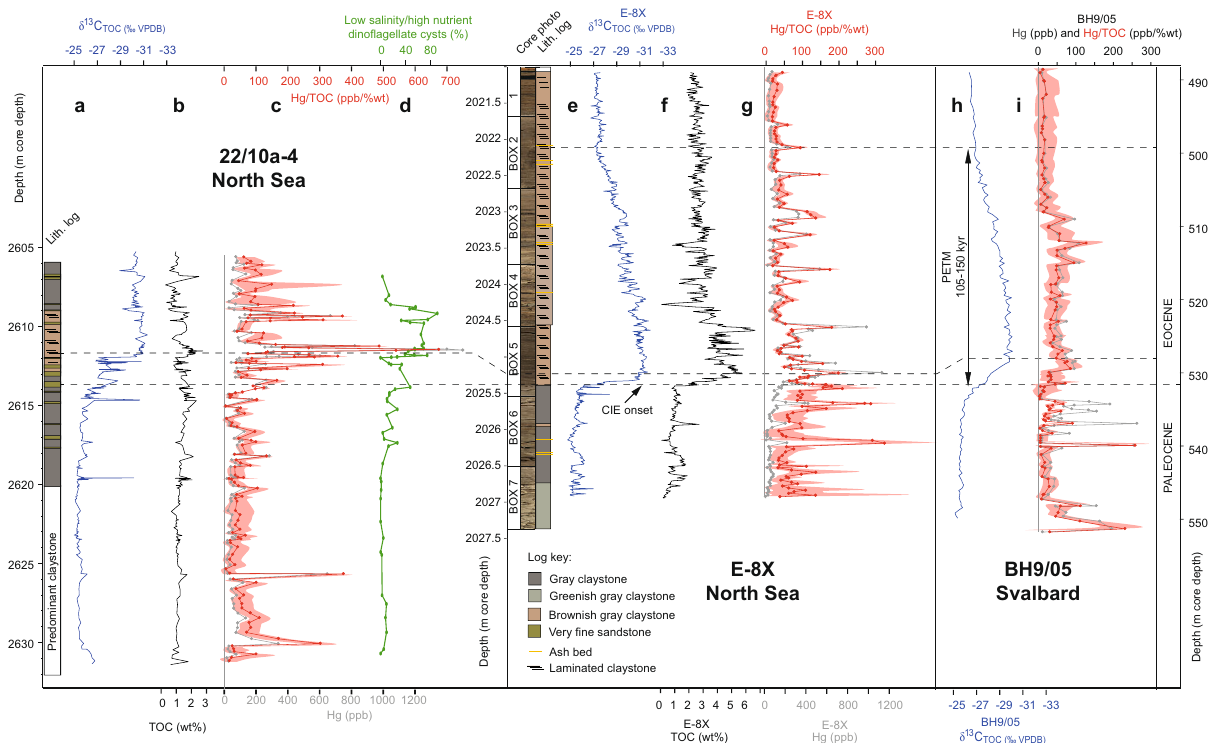
Fig. 2 Geochemical proxy records from the North Sea and Svalbard cores, showing volcanic and sedimentological changes associated with the Paleocene – Eocene Thermal Maximum (PETM). Records are shown against depth in m core depth (below oil rig fl oor ‘ Kelly bushing ’ for 22/10a-4 and E-8X). a – d Well site 22/10a-4 (North Sea). e – g Well site E − 8X (North Sea). h – i Core BH9/05 (Svalbard). Bulk sediment total organic carbon δ 13 C TOC is reported as ‰ VPDB, Vienna PeeDee Belemnite. Total organic carbon (TOC) is reported as % of the bulk weight. Hg is reported as parts per billion (ppb). Hg/TOC envelope re fl ects an analytical error, illustrating higher uncertainty in samples with lower TOC. The 22/10a-4 lithological (lith.) log, δ 13 C TOC , and TOC from are from (ref. 26 ). The BH9/05 δ 13 C TOC and age model are from (ref. 40 ), and Hg data are from (ref. 7 ). The position of the Paleocene/Eocene boundary, de fi ned as the onset of the PETM, is shown as a horizontal dashed